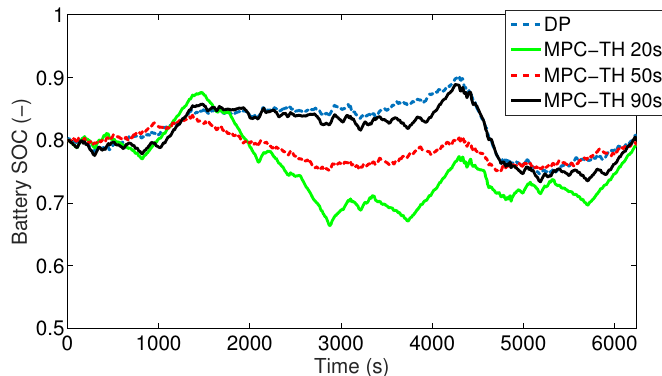
Figure 14. Battery SOC variations in MPC and DP controllers (EMC: 3-mode).